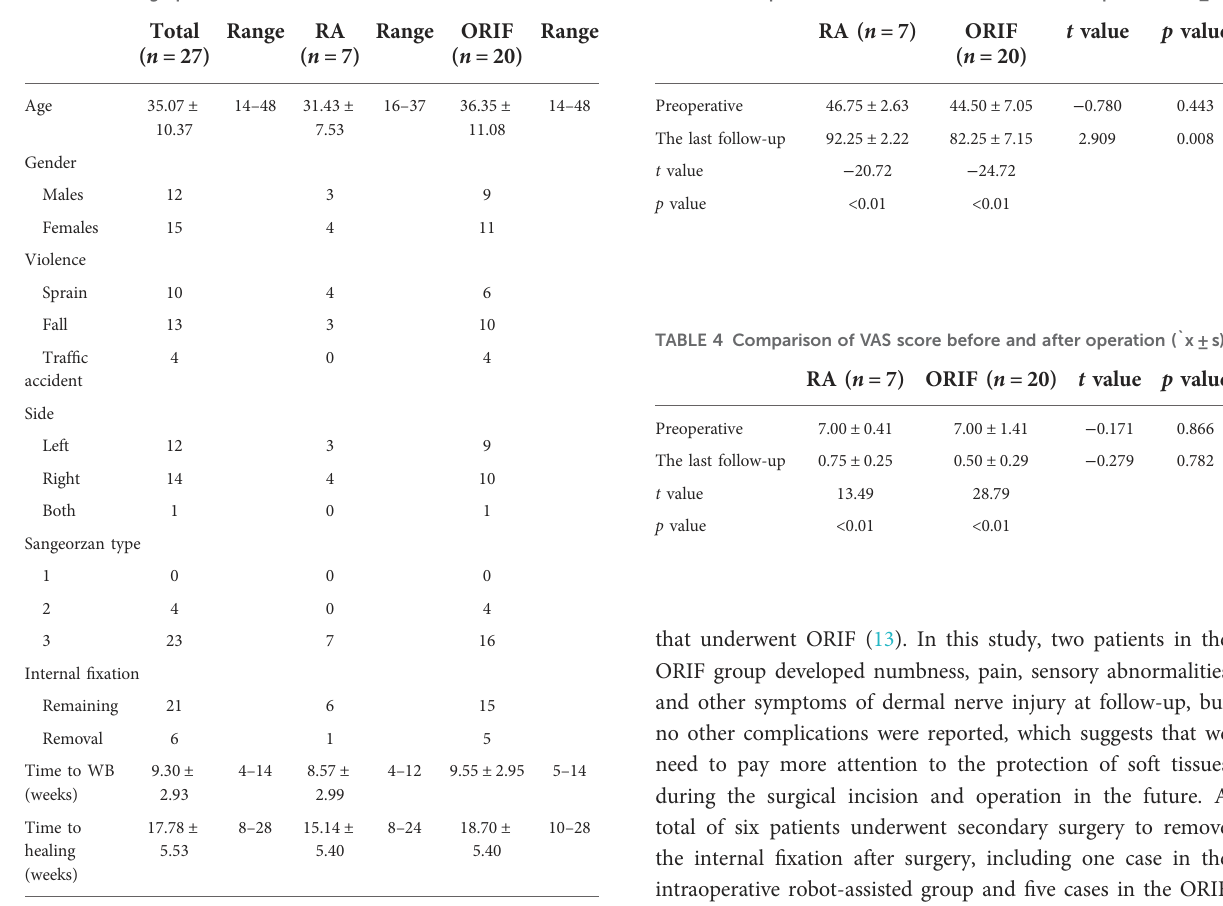
TABLE 1 Demographic data.